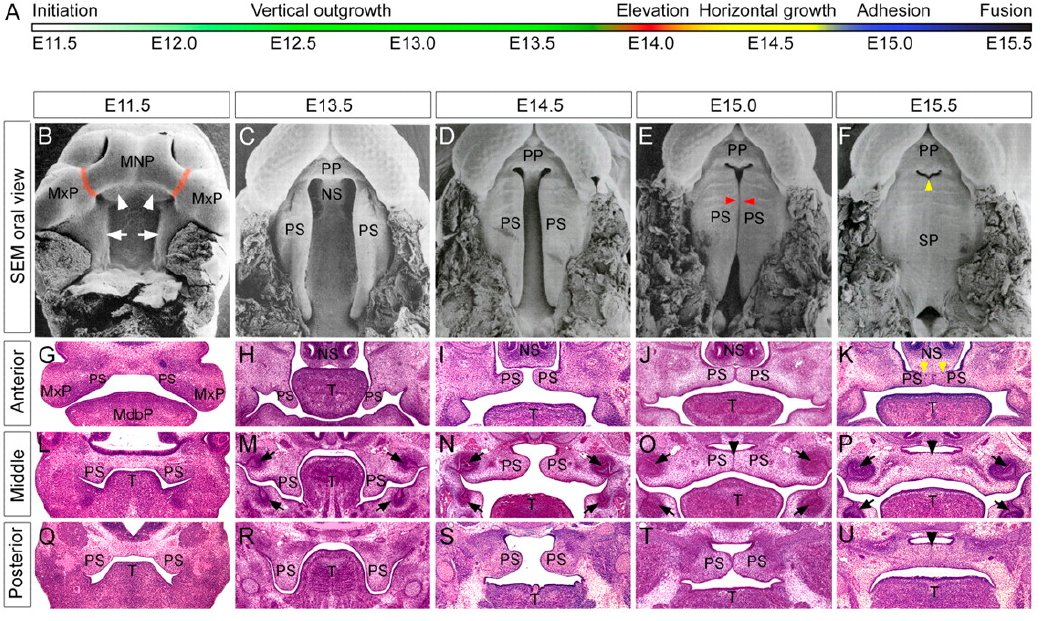
Figure 1. Normal mouse palatogenesis. Timeline of major developmental milestones in normal murine palatogenesis ( A ). Scanning electron microscopy of select developmental stages of murine palatogenesis as viewed from the oral cavity ( B – F ). Coronal H&E stained sections through anterior, middle, or posterior regions of the palate during selected developmental time points, E11.5 ( G , L , Q ), E13.5 ( H , M , R ), E14.5 ( I , N , S ), E15.0 ( J , O , T ), and E15.5 ( K , P , U ). MdbP, mandibular process; MNP, medial nasal process; MxP, maxillary process; NS, nasal septum; PP, primary palate; PS, palatal shelf; SP, secondary palate; T, tongue. (Reproduced/adapted with permission: Bush, J.; Jiang, R. Palatogenesis: morphogenetic and molecular mechanisms of secondary palate development. Development 2012 , 139